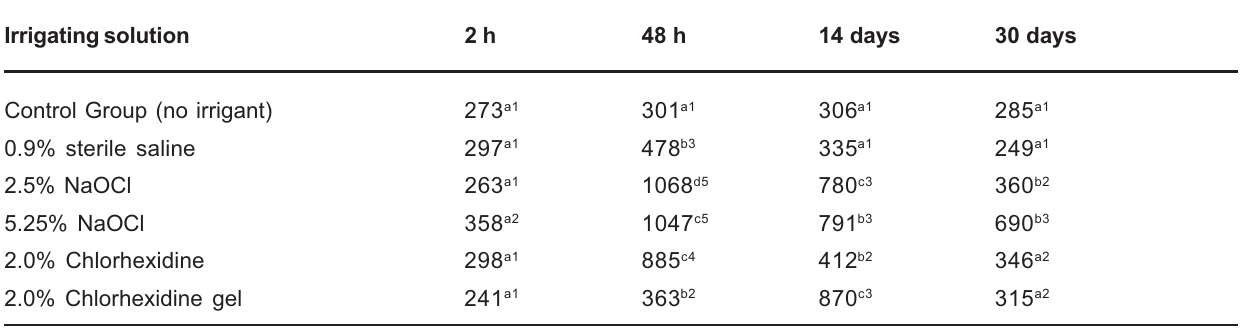
Tissue reaction to the solutions over time - Rows (p<0.05; different letters indicate statistically significant difference at 5%). Comparison among the solutions at the evaluation periods - Columns (p<0.05; Different indicate statistically significant difference at